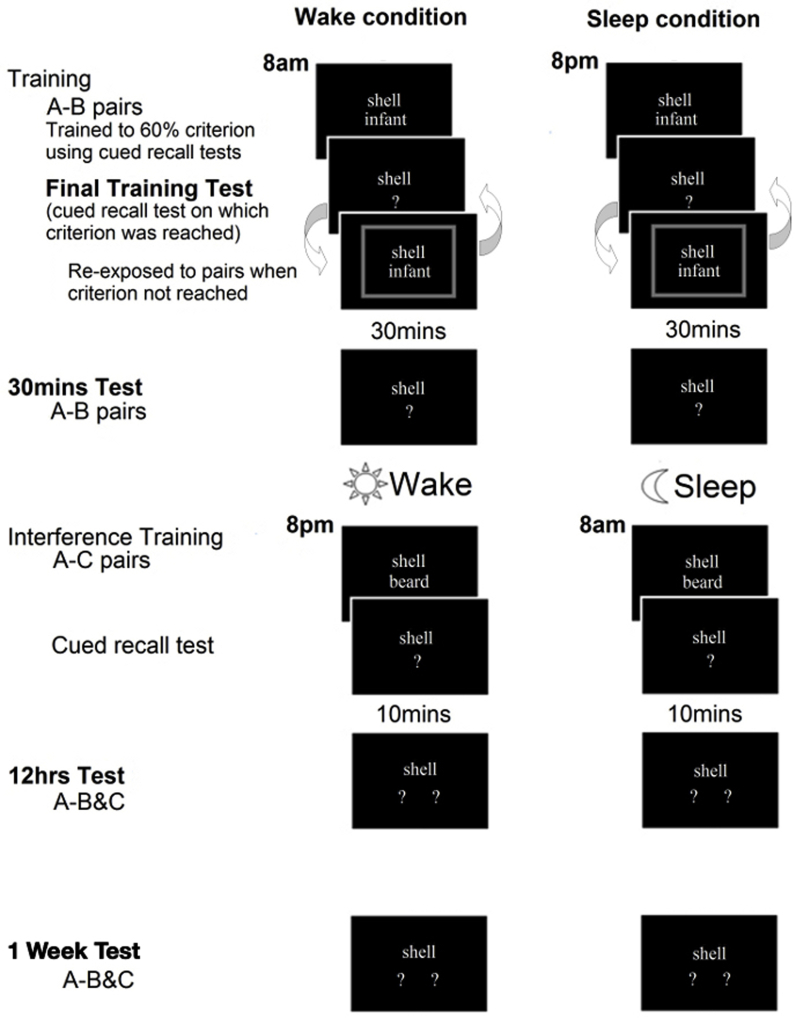
An illustration of the word-pair associates paradigm, adapted from Atherton et al. (2014). Memory performance was assessed using cued recall tests without feedback. During the initial training stage, until the participants reached criterion in one of the cued recall tests, they were repeatedly re-exposed to the full set of pairs, with coloured borders around each pair (green for correct and red for incorrect) providing feedback on their most recent response.